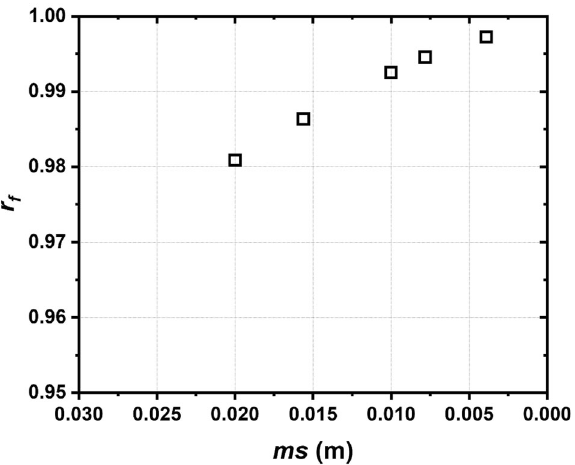
Fig. 7 Comparison between analytical solution and numerical solution. Relative fl ux ( r f ) ( = Numerically calculated fl ux × Analyti- cally calculated fl ux − 1 ) of HS − on Cu canister surface, as calculated for different canister and bentonite surface mesh sizes.